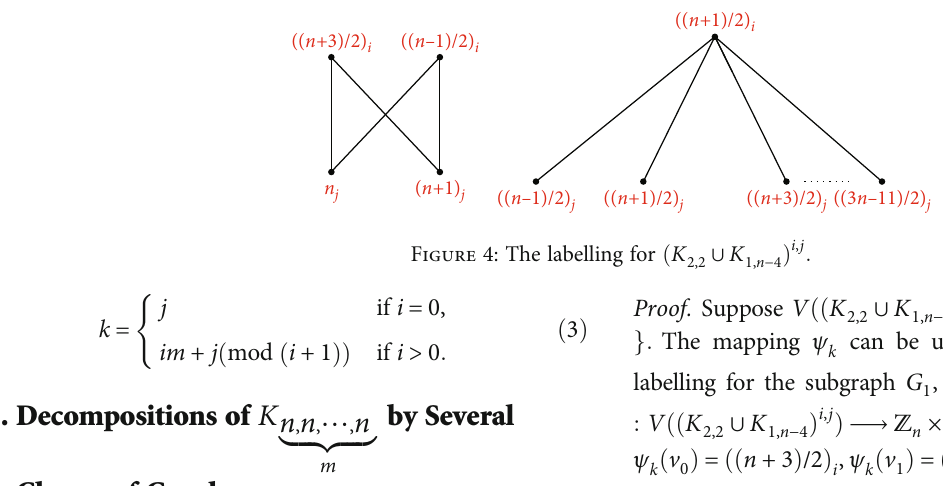
i , j ∪ K 2,2 1, n − 4 Þ